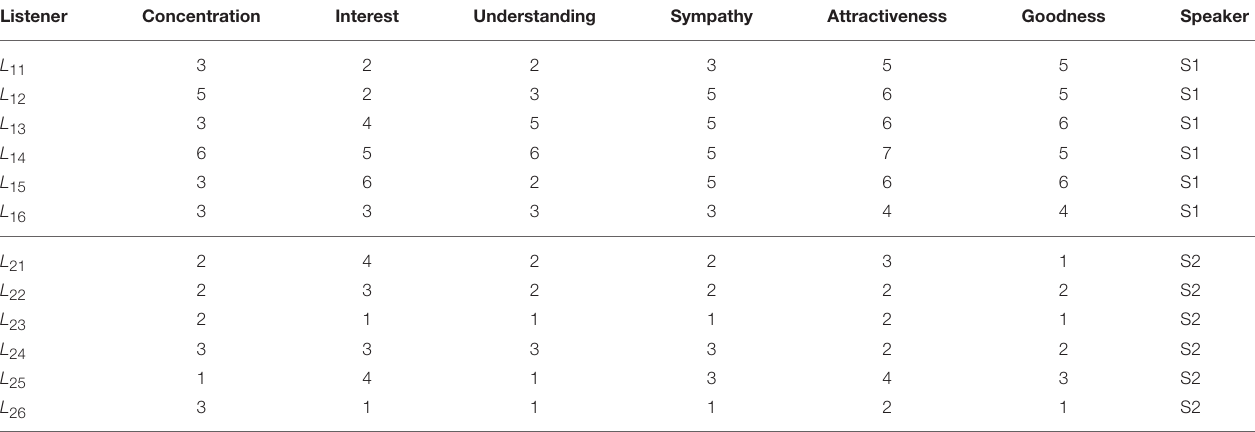
TABLE A2 | Results of the Questionnaire provided with the original data [5]: Listeners, the first column, self-rating experience (concentration, interest, understanding) of an unknown story, and sympathy to the appointed speaker and the speaker’s attractiveness and goodness. Listener Concentration Interest Understanding Sympathy Attractiveness